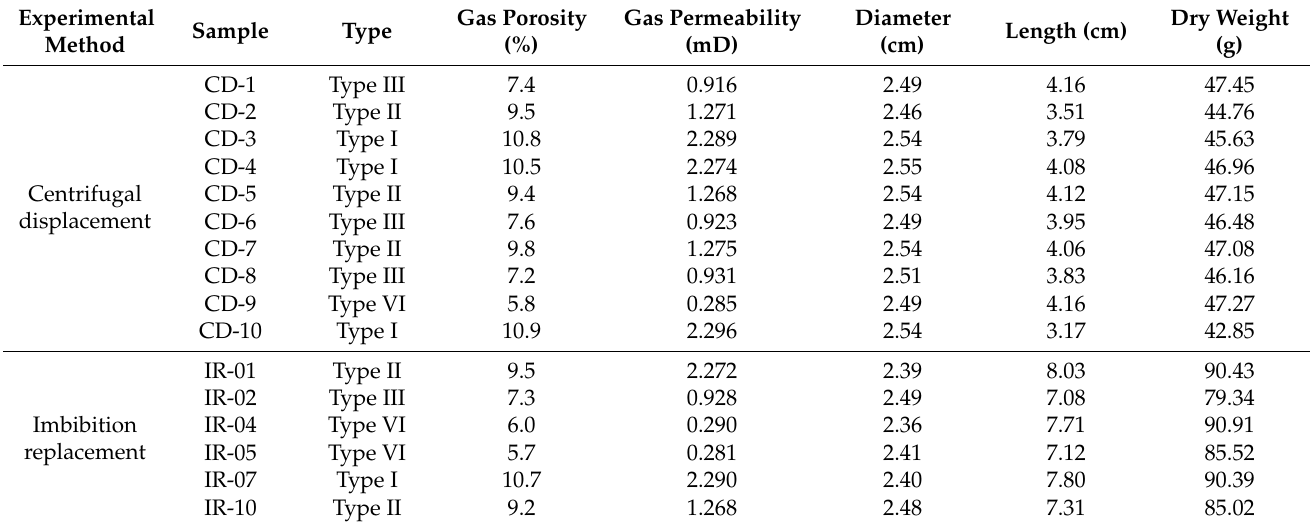
Table 2. Information on the experimental samples.